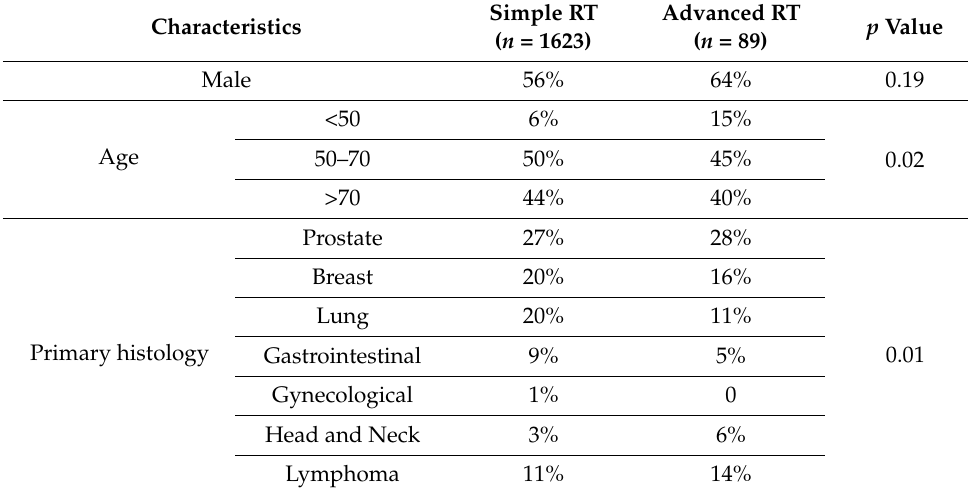
Table 1. Patient